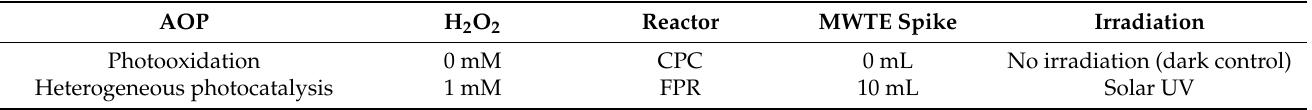
Table 3. Independent variables and their